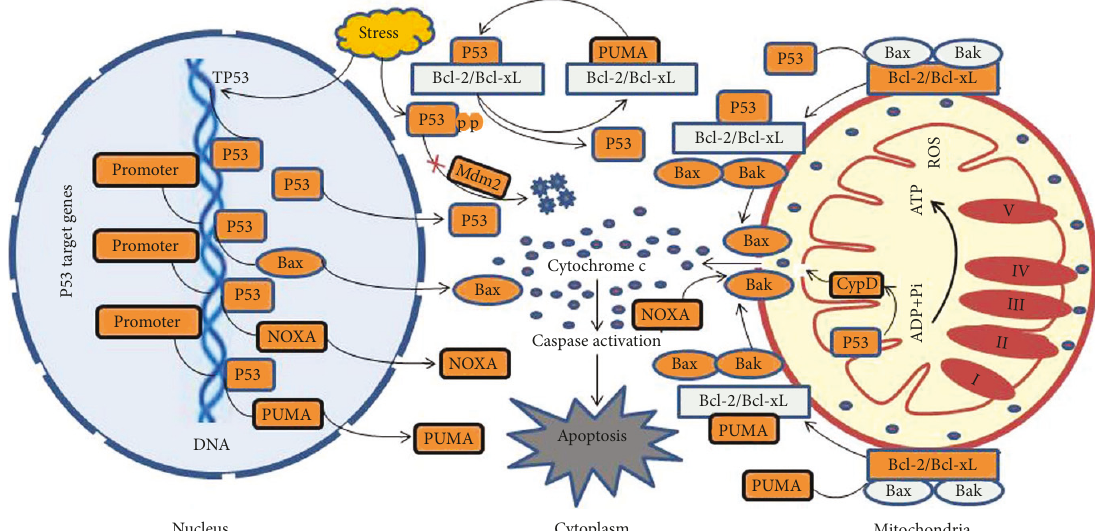
Figure 2: Association of p53 activation with mitochondria-mediated cell death. p53 is a response factor and becomes activated in response to cellular stress. Activation of p53 transactivates the expression of many proapoptotic proteins, including Bax, PUMA, and NOXA, which induces the opening of mPTP and initiates the mitochondria-mediated intrinsic cell death. p53 in response to cellular stress undergoes posttranscriptional modifications to control its activity and subcellular localization and to resist proteasomal deg- radation by Mdm2. Mitochondrial Bax and Bak are essential proapoptotic proteins that are combined with the antiapoptotic Bcl2 protein under normal conditions. Activation of p53 interacts with Bcl-2/Bcl-xL and releases Bax/Bak to opening mPTP, leading to the release of cytochrome c from the mitochondria into the cytosol and subsequent caspase activation. p53 transcriptionally activates proapoptotic protein PUMA to induce mPTP formation. PUMA contributes to the release of p53 from Bcl-xL complex into cytosol, resulting in p53- dependent Bax/Bak activation and subsequent permeabilization in the outer mitochondrial membrane. PUMA also directly interacts with proapoptotic proteins Bax and Bak to open mPTP and release cytochrome c. NOXA is a p53 target protein that impairs mi- tochondria via mPTP triggering intrinsic cell death. Mitochondrial p53 also interacts directly with CypD to open mPTP and trigger